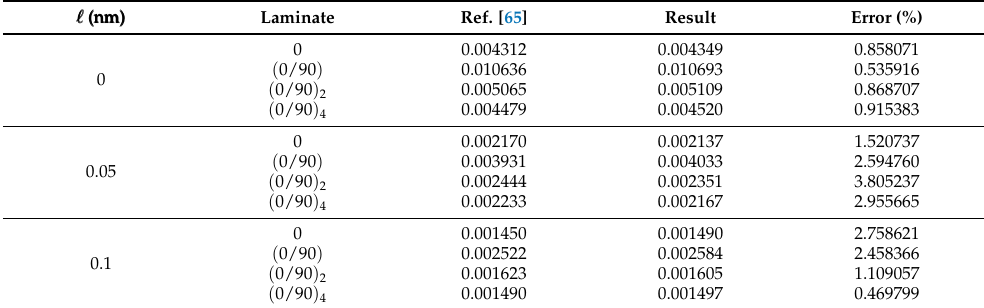
Table 7. Non dimensional values of ¯ w mid deflection for composite nanoplates, obtained for α C = 1.85, q = − 1.6, α s =